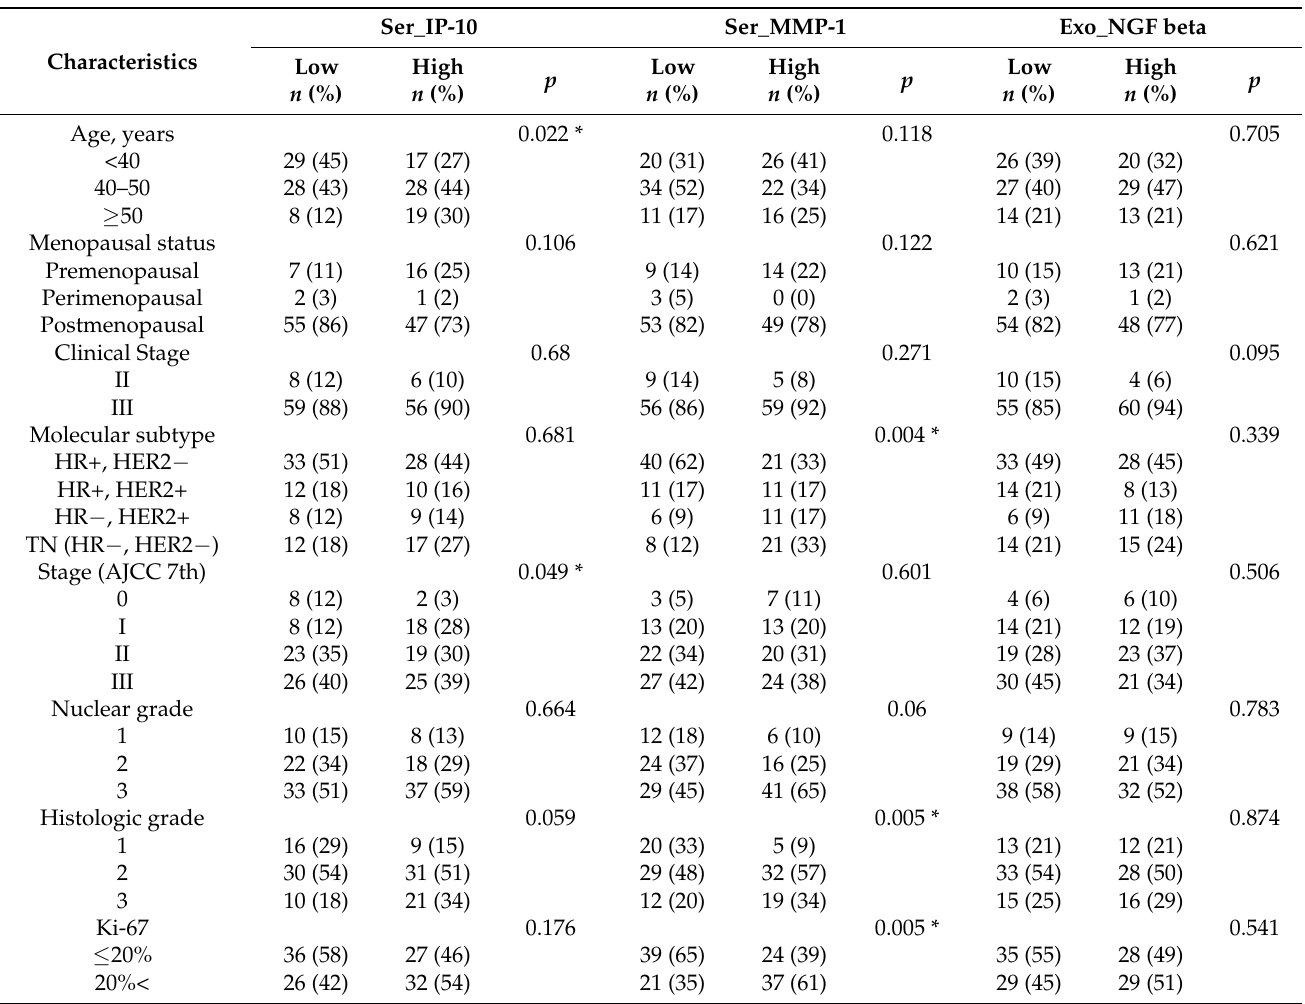
Table 3. Associations of serum IP-10, serum MMP-1 and exosomal NGF levels with clinical characteristics.